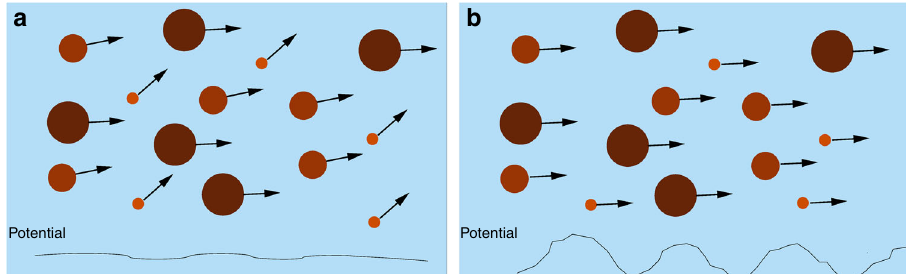
Fig. 1 Illustration of the motion of skyrmions with different sizes in the presence of disorder. Schematic of the experiments by Zeissler et al. 14 , who use imaging to examine moving skyrmions with different diameters. The skyrmions move at an angle with respect to the drive known as the skyrmion Hall angle. a The results expected if the skyrmion Hall angle depends on the size of the skyrmions, with different size skyrmions moving at different angles. This can occur if the background potential is weak. b The observed results in which the skyrmion Hall angle is independent of skyrmion diameter. The skyrmions undergo plastic motion due to strong interaction with the pinning sites, implying a strong underlying disordered